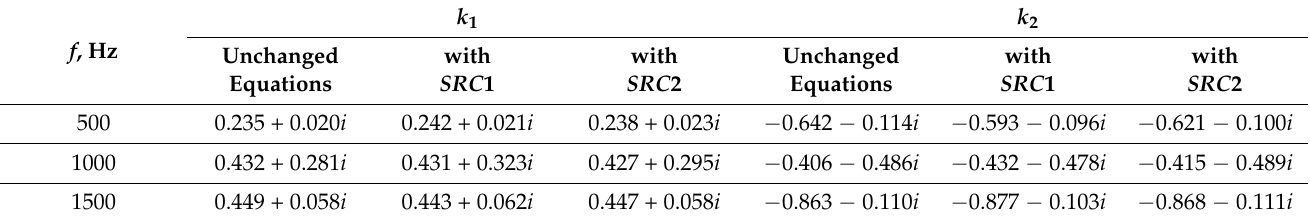
Table 1. LSA predictions of acoustic complex eigenvalues k x for original Navier-Stokes equations and equations with added stabilization source terms SRC 1 (7) and SRC 2 (9). k 1 k